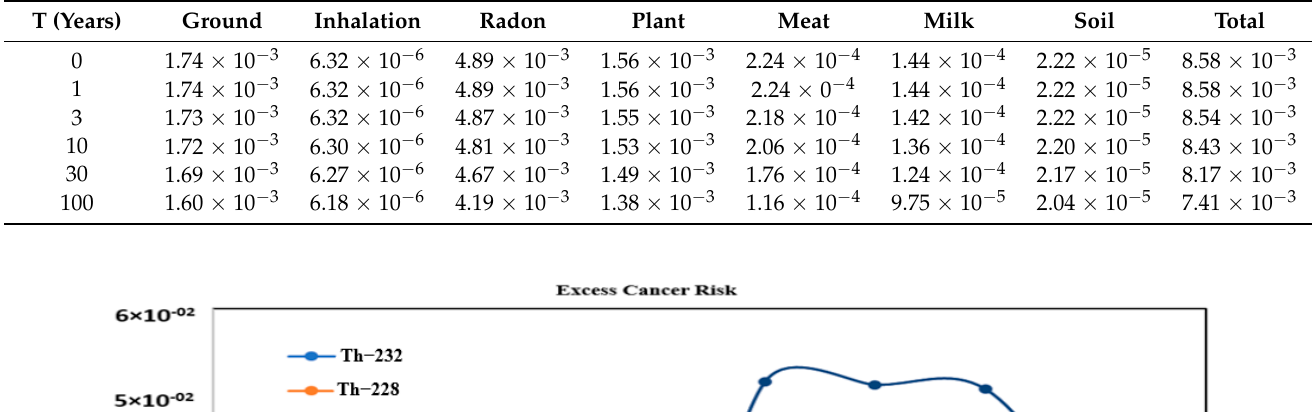
Table 6. Total ECR for initially existent radionuclides and pathways and fraction of total risk.